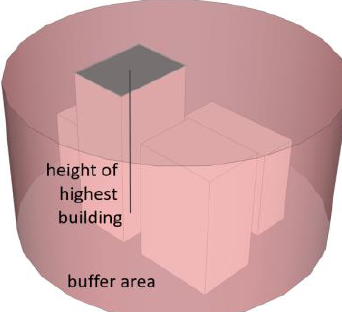
Figure 2. 3D buffer and corresponding buildings for the calculation of the ‘porosity’.